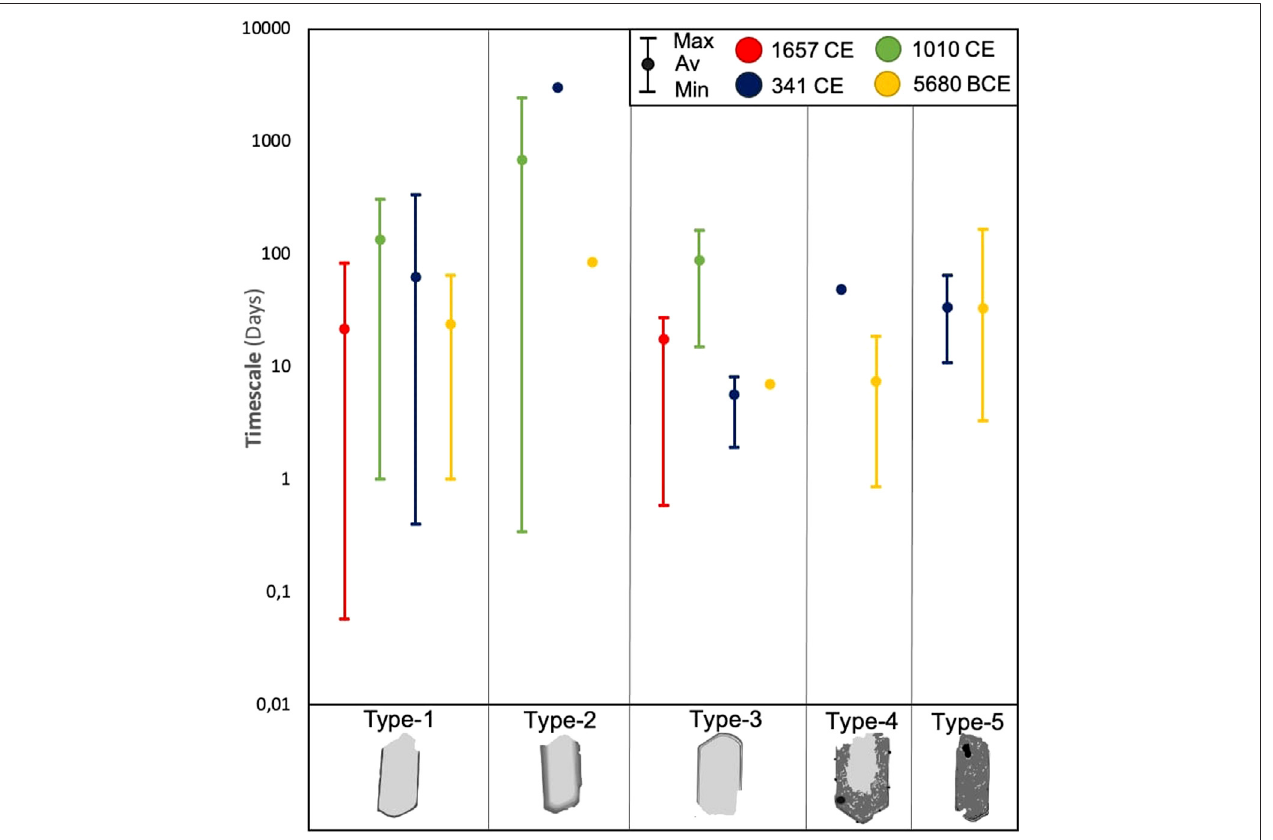
FIGURE 12 | Maximum, minimum and average timescale values for the different crystal populations recorded in each eruption. For single points, only one crystal wasidenti fi ed. Thelargestrange ofvaluesareobservedinthesimplecrystalsType-1 andType-2; however,thismaybeare fl ection ofpopulationsize.Type-1 isfoundin all eruptions and records the shortest timescales. Type-2, is mainly found in the 10101 Cal. CE eruption and records the longest timescales and a large range of timescales. Type-3 has the fewest number of crystals and shows the smallest range of values.While the 1657 Cal. CE, ∼ 341 Cal. CE and 5680 Cal. BCE eruptions show similar averages, the 1010 Cal. CE eruption shows a higher average and minimal overlaps with the other eruptions.